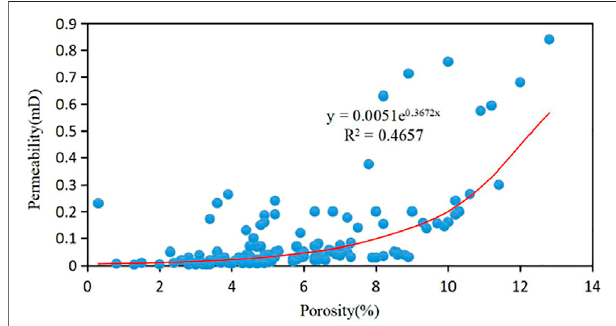
FIGURE 5 | Pore types (red arrows) of the Upper Paleozoic reservoirs in the Dongpu Depression. (A) Primary intergranular residual pores of the Upper Shihezi Formation of the Qinggu 2 Well at a well depth of 3,796.70 m; (B) Primary intergranular residual pores of the Shiqianfeng Formation of the Weigu 2 Well at a well depth of 3,663.9 m; (C) Intergranular dissolution pores of the Shiqianfeng Formation of the Mao 8 Well at a well depth of 1,652 m; (D) Intergranular dissolved pores of the Lower Shihezi Formation of the Ma 21 Well at a well depth of 3,403.08 m; (E) Intragranular dissolved pores of the Lower Shihezi Formation of the Ma 21 Well at a well depth of 3,403.08 m; (F) Rock fragments Intragranular dissolution pores of the Lower Shihezi Formation of the Ma 71 Well at a well depth of 3,597 m; (G) intercrystalline micropores of the Taiyuan Formation of the Donggu 2 Well at a well depth of 2,352.16 m; (H) crushing microfractures of the Upper Shihezi Formation of the Ma 17 Well at a well depth of 3,466.10 m; (I) diagenetic contraction microfractures of the Shiqianfeng Formation of the Pushen 8 Well at a well depth of 5,333.40 m.